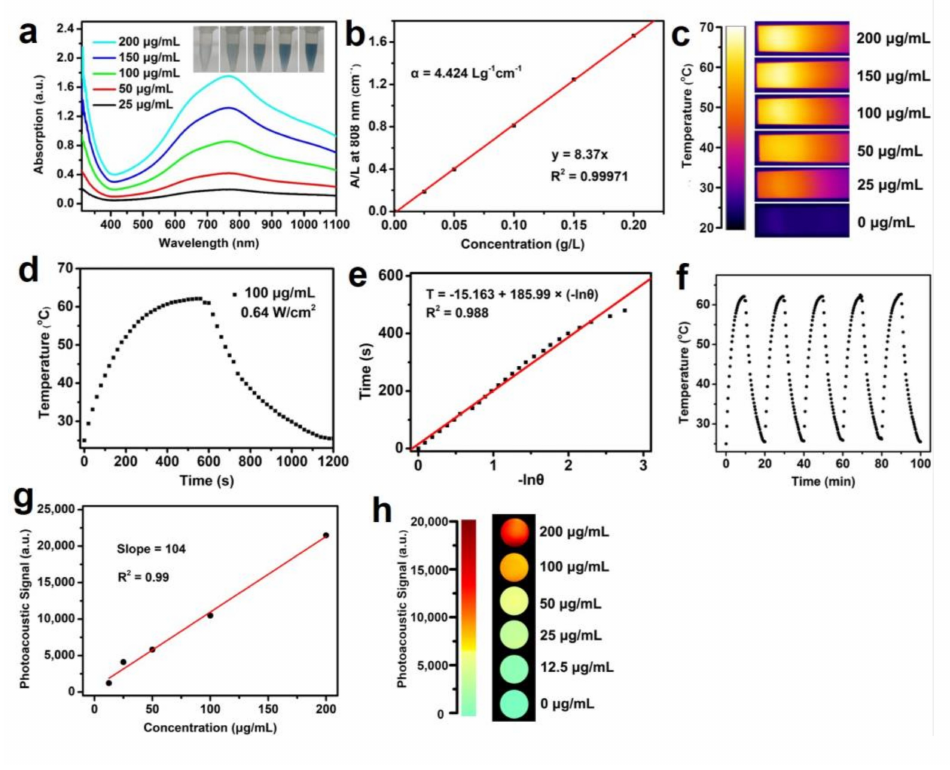
Figure 3. ( a ) UV-vis − NIR absorbance spectra of Mo 2 C QDs in aqueous solutions at varied concentrations. Insets are the photographs of Mo 2 C QDs with different concentrations (25, 50, 100, 150, and 200 µ g/mL); ( b ) Normalized absorbance intensity for λ = 808 nm at different concentrations; ( c ) Thermal infrared images of Mo 2 C QDs in aqueous solution under 808 nm laser irradiation; ( d ) Photothermal curves of Mo 2 C QDs solutions irradiated with a 808 nm laser (0.64 W/cm 2 ); ( e ) The linear time data versus − ln θ obtained from the cooling curve; ( f ) Photothermal stability of Mo 2 C QDs solution (100 µ g/mL) over five NIR laser on/off cycle irradiation; ( g ) The linear correlation between photoacoustic (PA) intensities and Mo 2 C QDs concentrations in the range from 0 to 200 µ g/mL; ( h ) PA imaging phantoms of Mo 2 C QDs at various